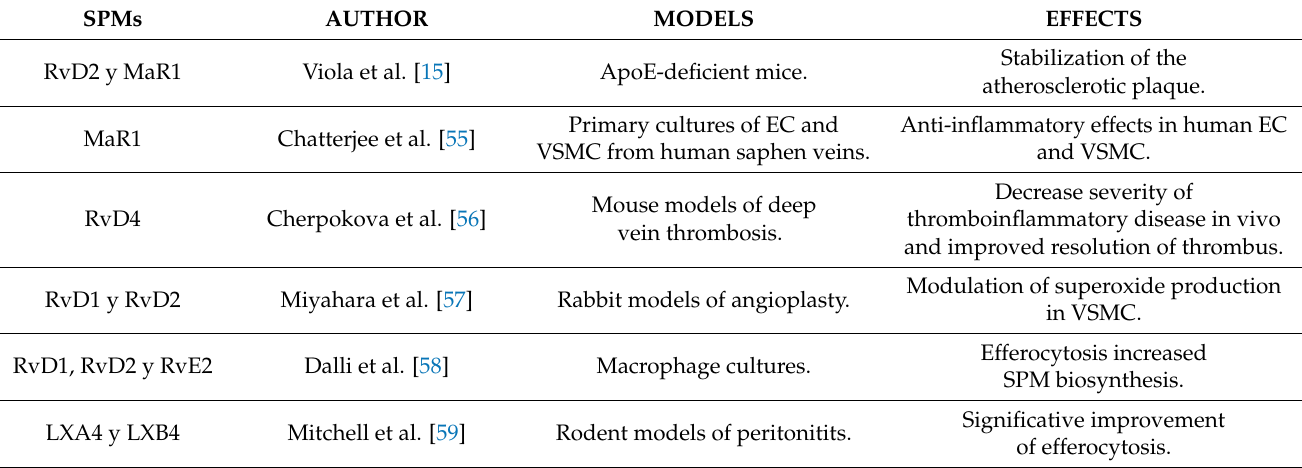
Table 2. Evidence for the action of SPMs in the pathogenesis of